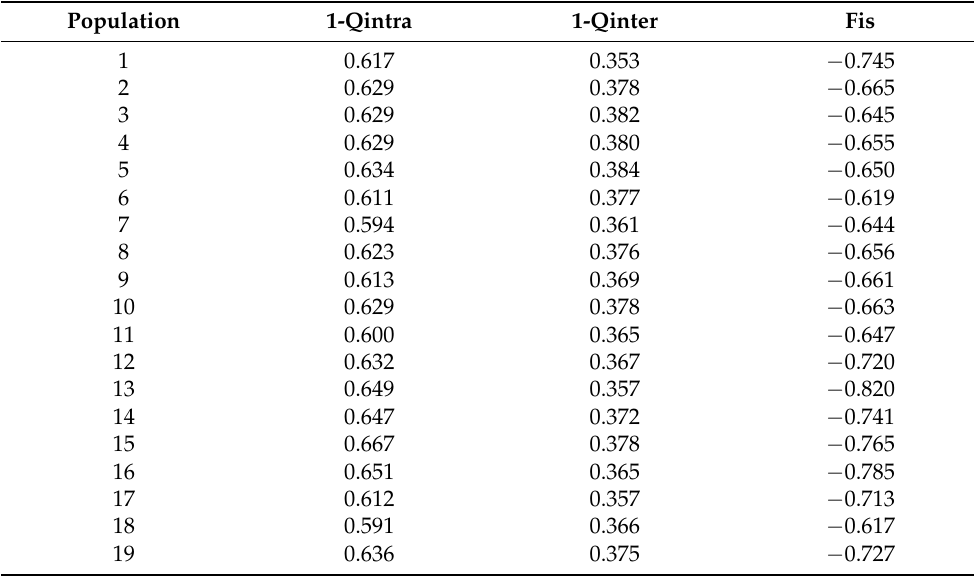
Table 2. Genetic variances (inter- and intra-population) and fixation index (Fis) per population from the Brazilian E. oleifera Germplasm Bank for the set of 1667 SNP loci. 1-Qintra: intrapopulation allelic diversity. 1-Qinter: interpopulation allele diversity. Fis: diversity measure. Population 1-Qintra